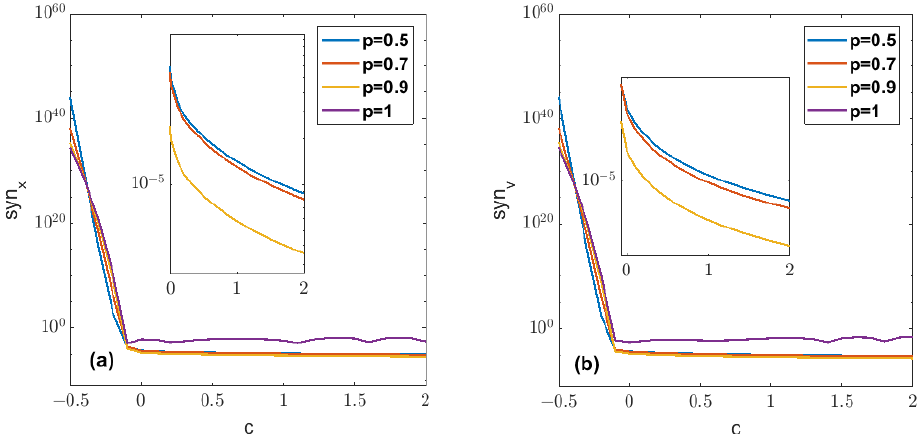
Figure 8. The average synchronization error 𝑆𝑦𝑛 𝑥 ( a ) and 𝑆𝑦𝑛 𝑣 ( b ) as functions of the position coupling strength 𝑐 with different orders 𝑝 = 0.5,0.7,0.9,1 .